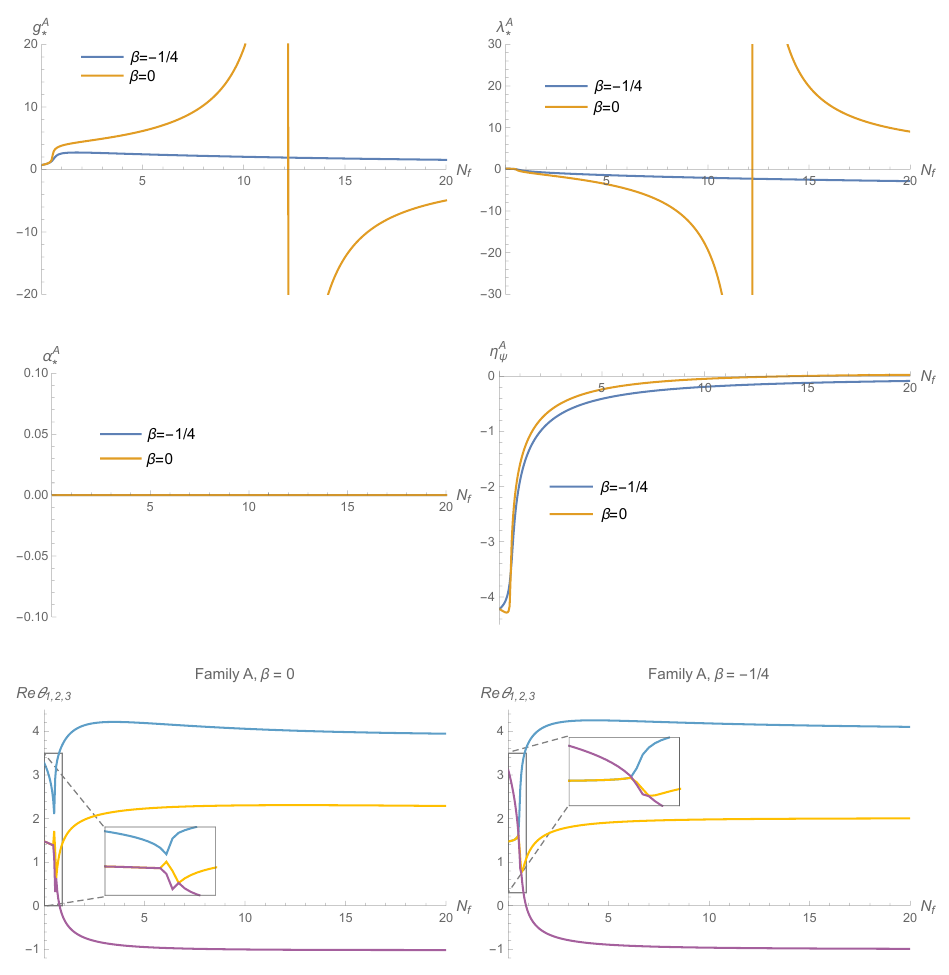
Figure 12. Characteristic properties of Family A obtained from investigating the system Equations (26) and (29) with A 0 = 0. The first three diagrams show the position of the fixed points as a function of N f for β = − 1/4 (blue line) and β = 0 (orange line). NGFP A exists for all values N f and is characterized by α A ∗ = 0. The fermion anomalous dimension at the fixed points is depicted in the fourth diagram, showing no structural differences with respect to the previous section apart from the disappearance of the bounds (55). The stability analysis identifies two UV-attractive and one UV-repulsive stability coefficient for values of N f extending beyond the window (55), indicating that NGFP A is a saddle point in the { g , λ , α } -plane. For smaller values of N f , the stability analysis identities three UV-attractive stability